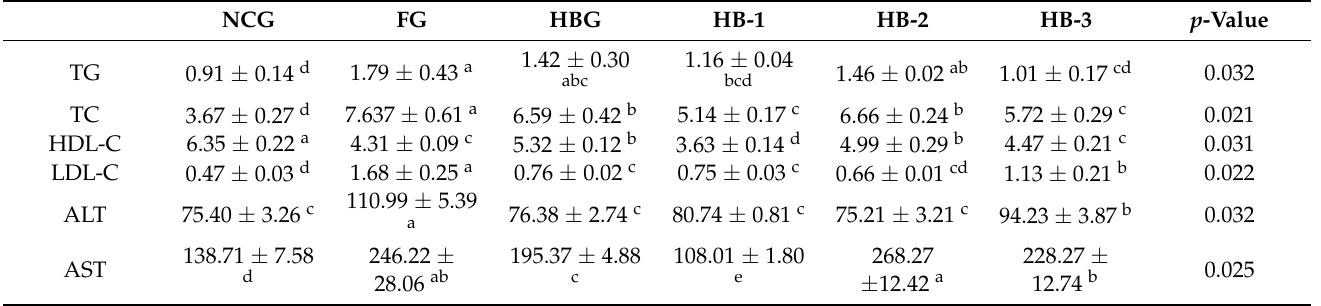
Table 4. Effect of HB, HB-1, HB-2, and HB-3 on the serum biochemical parameters in HFCD-fed